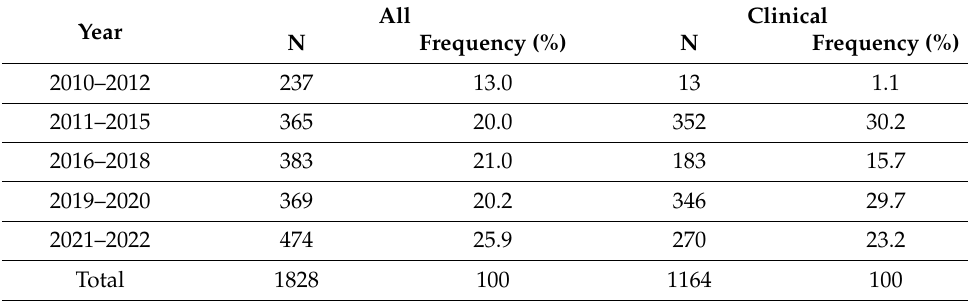
Table 1. Distribution of S. agalactiae sequences in NPDIB by year of reporting.